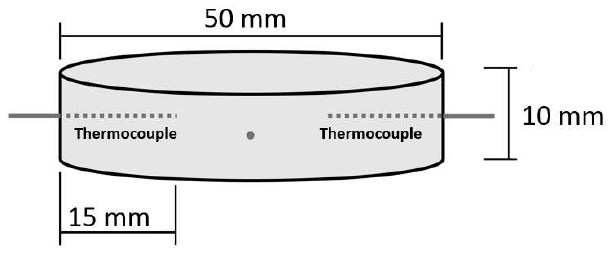
Figure 2. Sketch of metal disc with four inserted type K mantle thermocouples (with 1.6-mm diameter) at 90° horizontal separation.